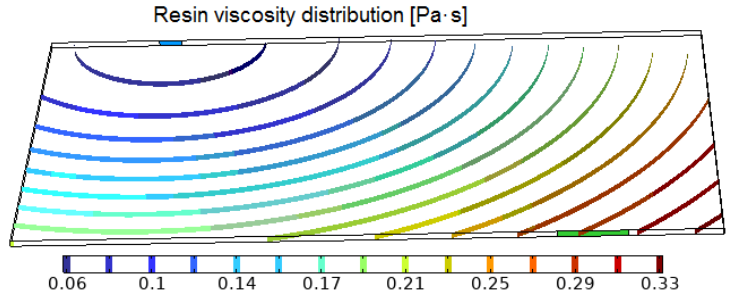
Figure 6. Spatial distribution of liquid resin viscosity.